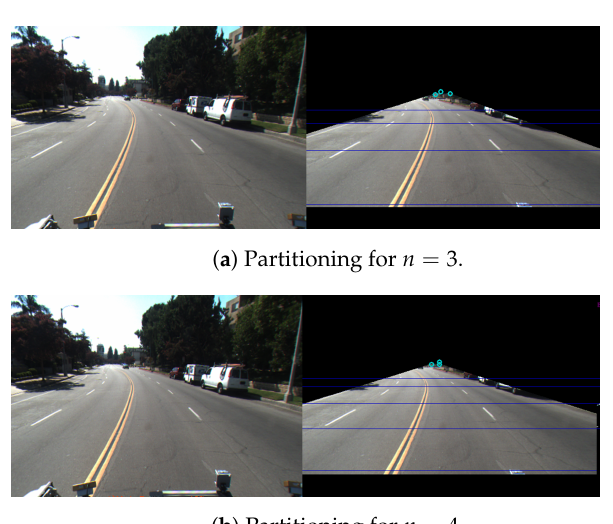
Figure 4. Two different examples of partitioning outputs (right) for the same input image (left). H , h 2 = 2 H and h 3 = 4 ( a ) n = 3 and h 1 = 1 7 7 h 4 = 5 H 11